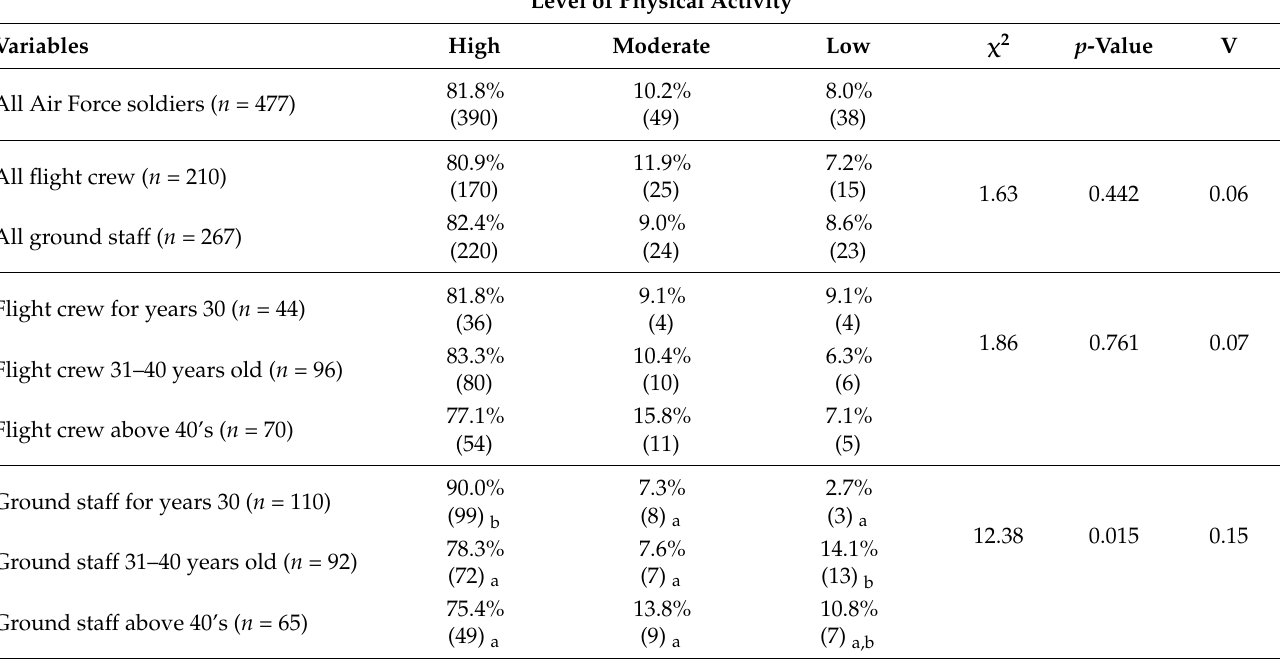
Table 1. Summary of the levels of physical activity of the Air Force soldiers according to the IPAQ